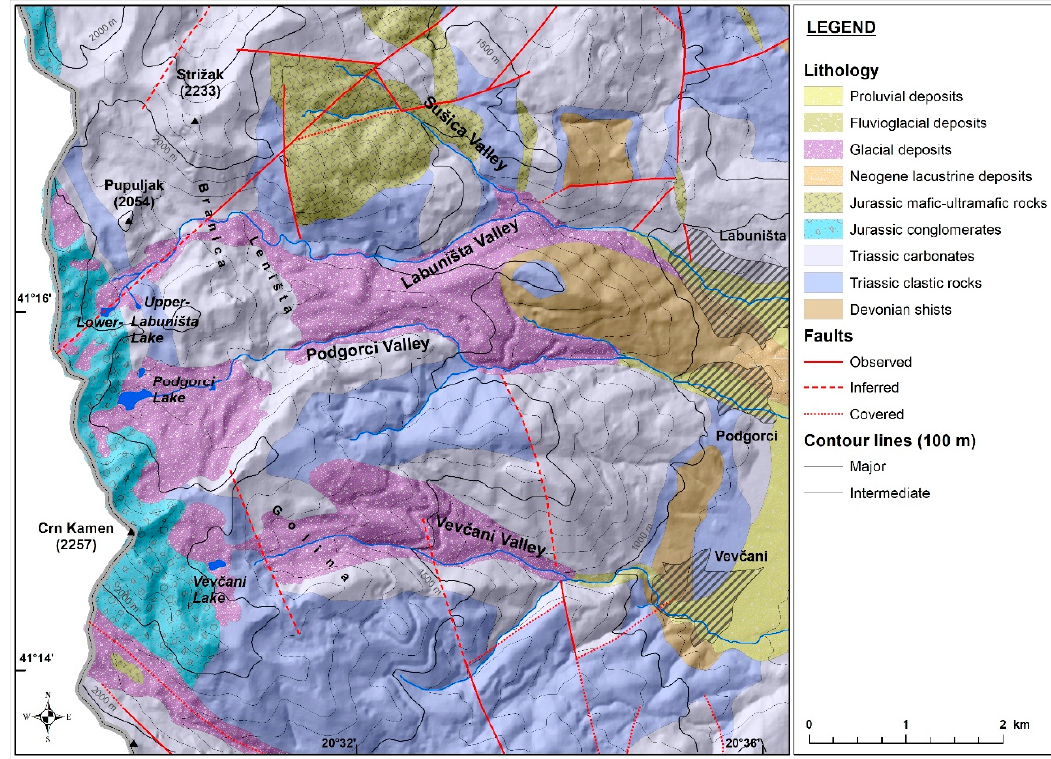
Figure 2. General geological map of the study area on Jablanica Mountain.